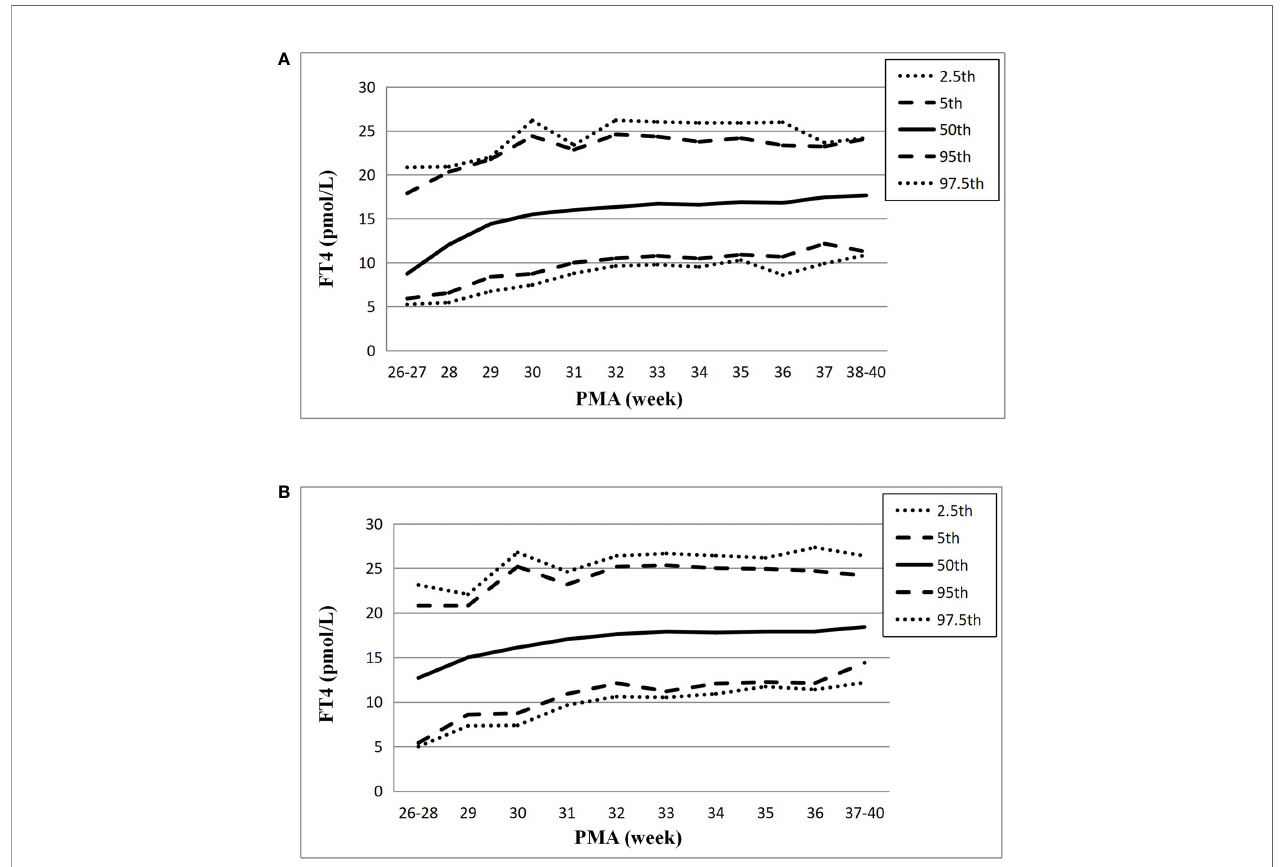
FIGURE 3 | Reference chart of FT4 based on PMA in preterm infants born with GA < 32 weeks. (A, B) represent the percentile charts of FT4 based on PMA in total 27 NICUs and 17 NICUs using the same measurement assay, respectively.